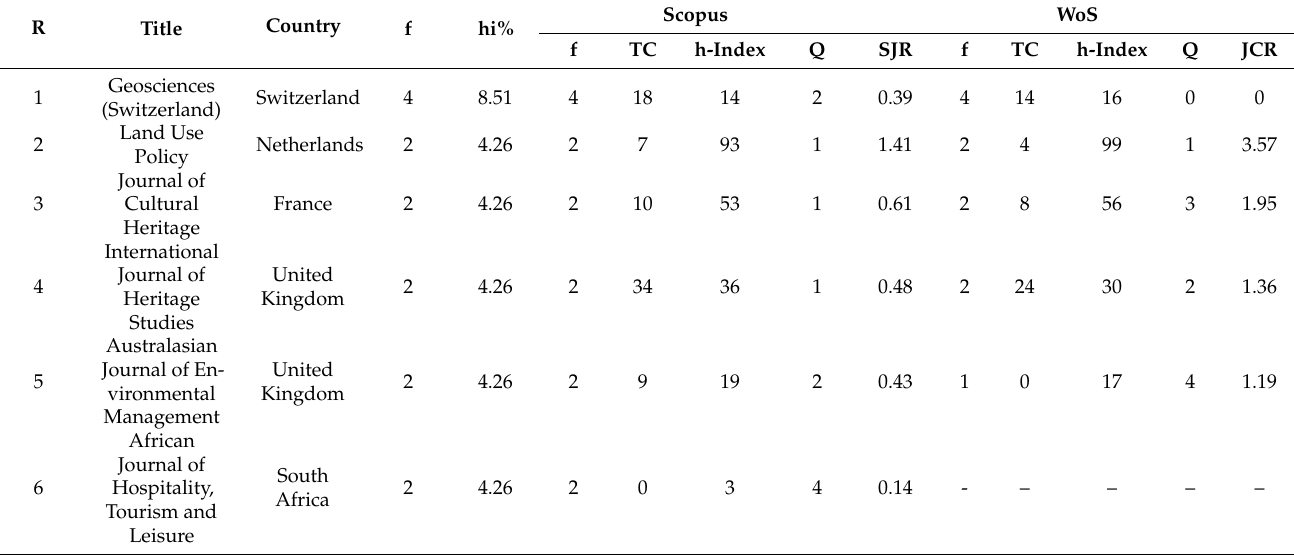
Table 6. Ranking of the most productive journals.